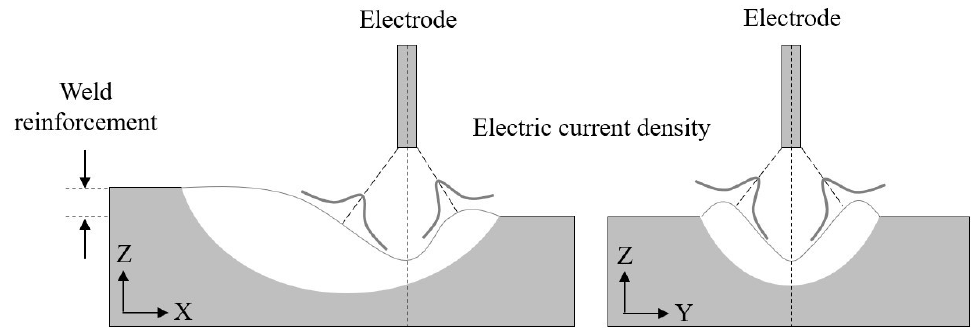
Figure 5. Current density distribution on the surface of the molten pool.